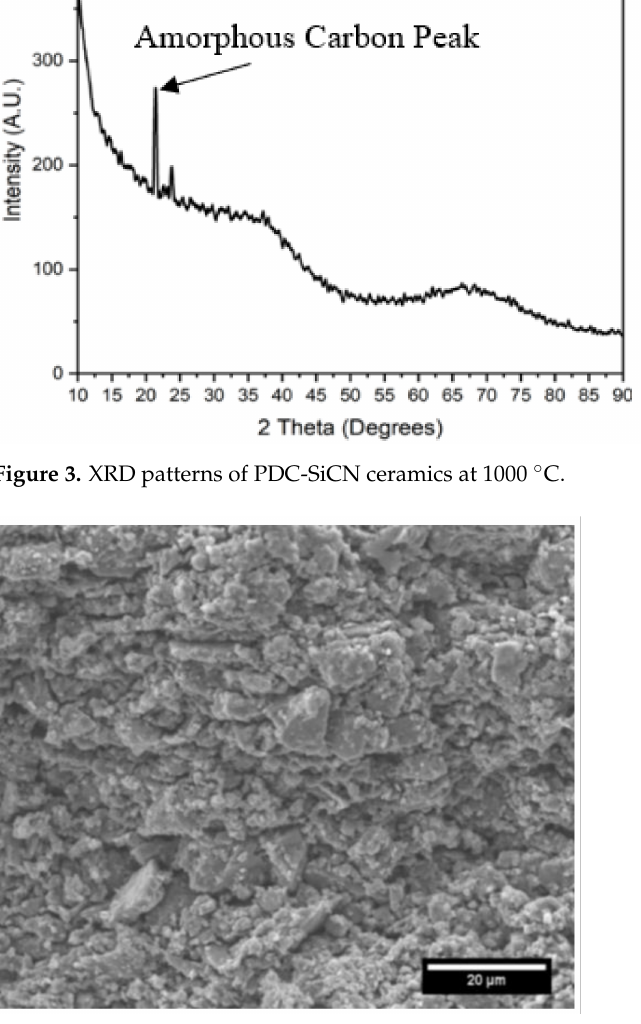
Figure 4. SEM image of PDC-SiCN pyrolyzed at 1000 ◦ C showing the amorphous nature of the